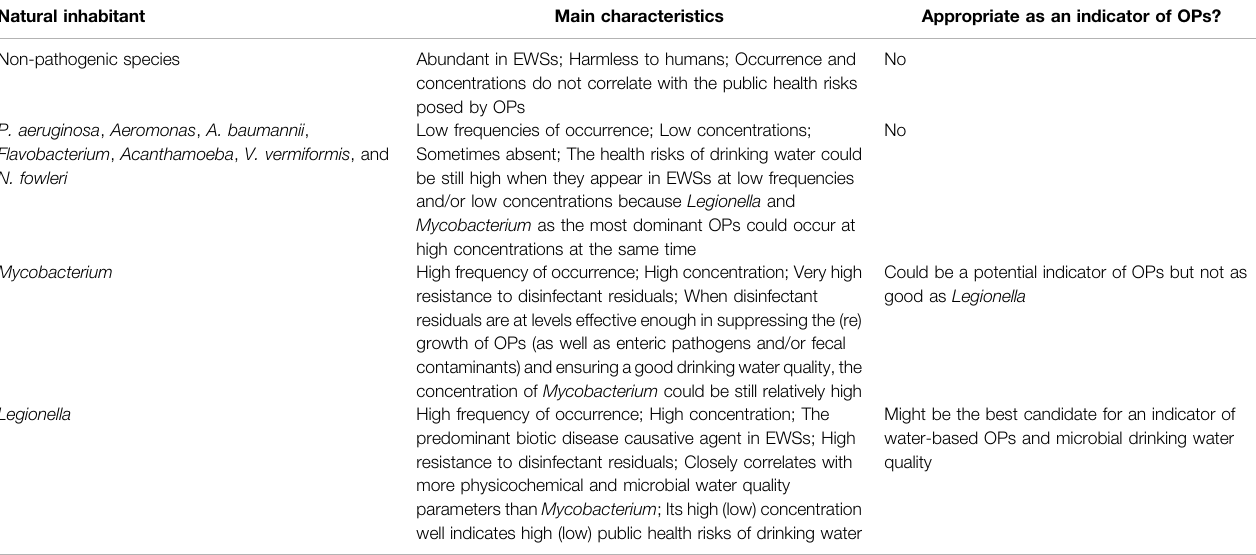
TABLE 1 | A brief comparison for the appropriateness of common natural inhabitants in municipal engineered water systems (EWSs) as indicators of opportunistic pathogens (OPs). Natural